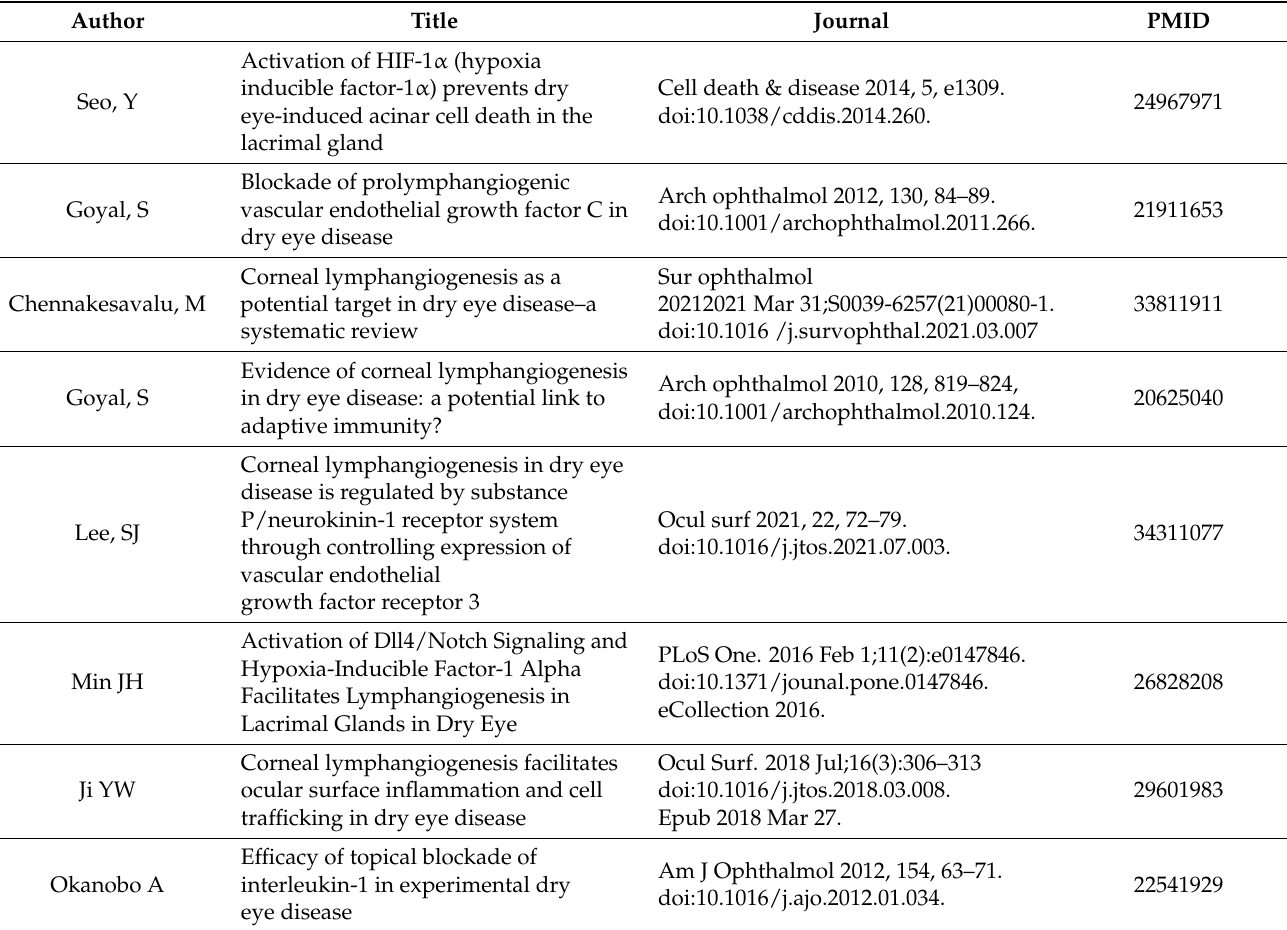
Table 2. Recent literature on dry eye disease and